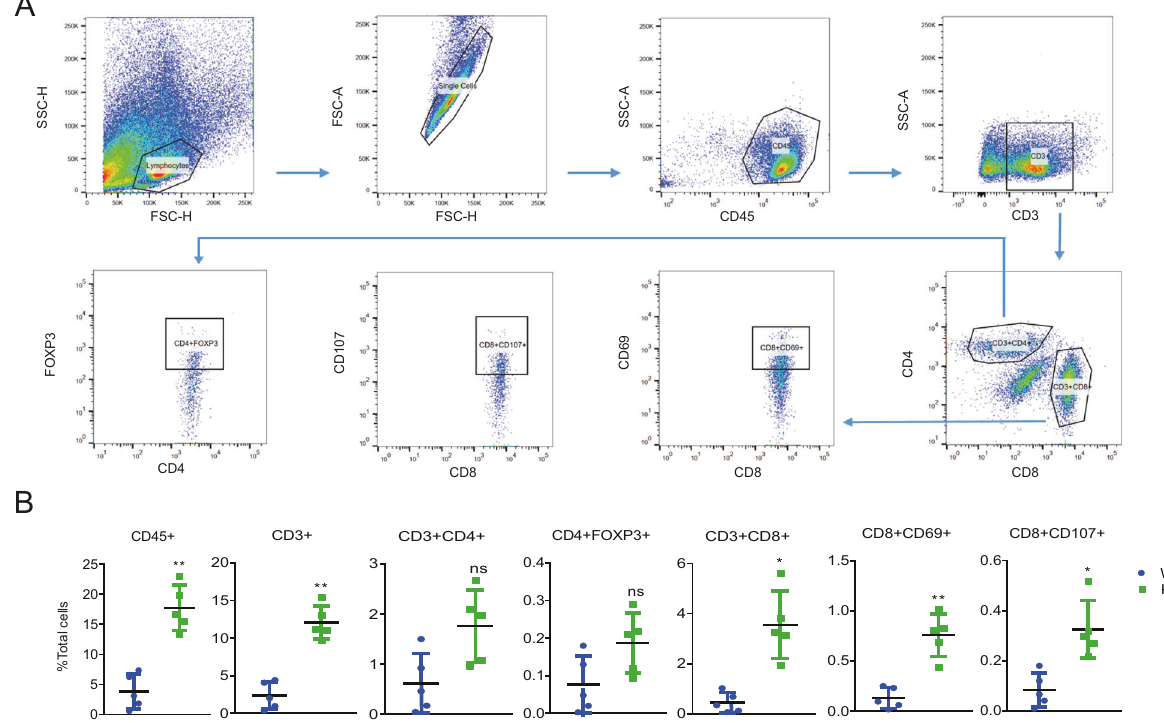
Fig. 6 HDAC2 knockout promoted tumor lymphocyte in fi ltration. A , B The Balb/c mice were sacri fi ced at 33 days after WT and HDAC2-KO cells ’ (4T-1) inoculation, and tumors of each group were isolated, and the in fi ltration of lymphocytes was analyzed by fl ow cytometry using the indicated antibodies. Gating strategy ( A ) and representative plots (KO group) are shown. Proportions of CD45 + , CD3 + , CD3 + CD4 + , CD3 + CD4 + FOXP3 + , CD3 + CD8 + , CD3 + CD8 + CD69 + , and CD3 + CD8 + CD107 + T cells in tumors of each group ( B , n =